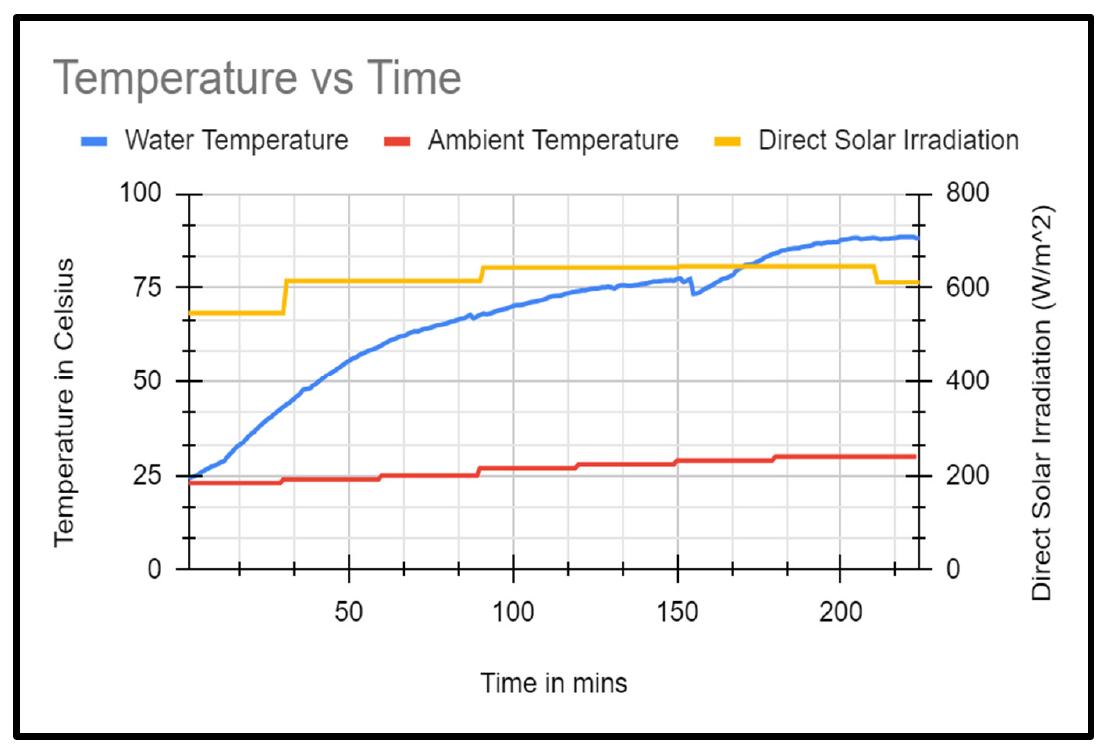
Figure 7. Temperature and irradiation values from day 1 using water as test load.